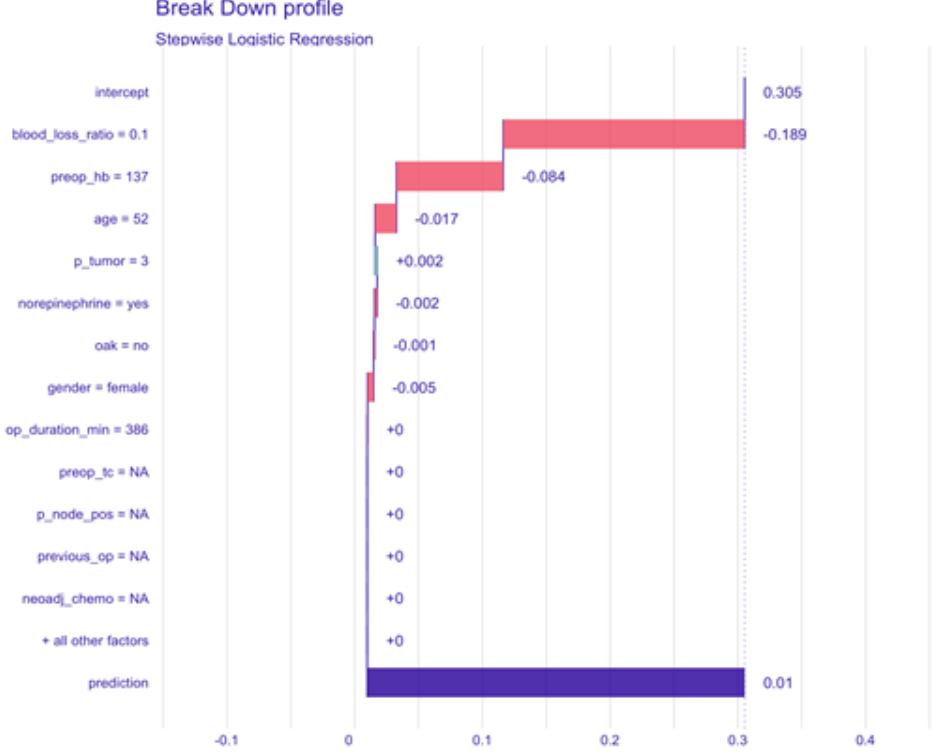
Figure A4. Younger female patient with normal hemoglobin level and lower blood loss (probability of transfusion: p trans = 1%).